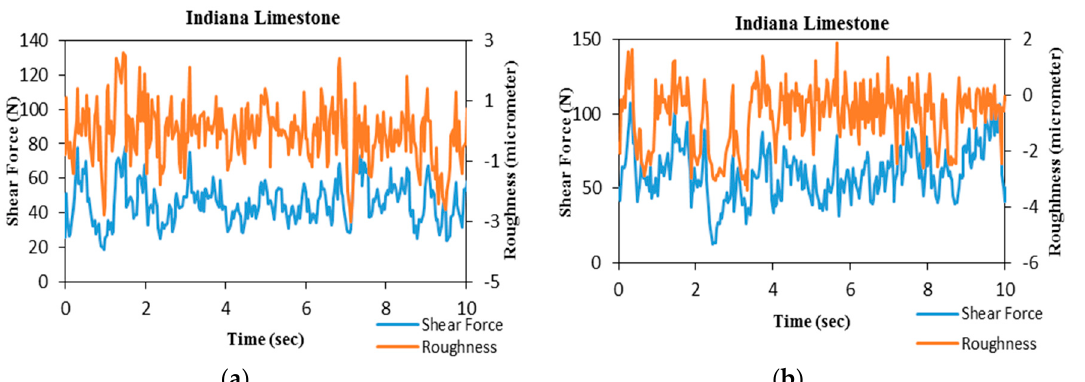
14 of 22 Figure 16. Evolution of 𝑅 (cid:3047) versus ∆𝑅 graph slope with the cutting depth for Berea sandstone. 4.2. Indiana Limestone